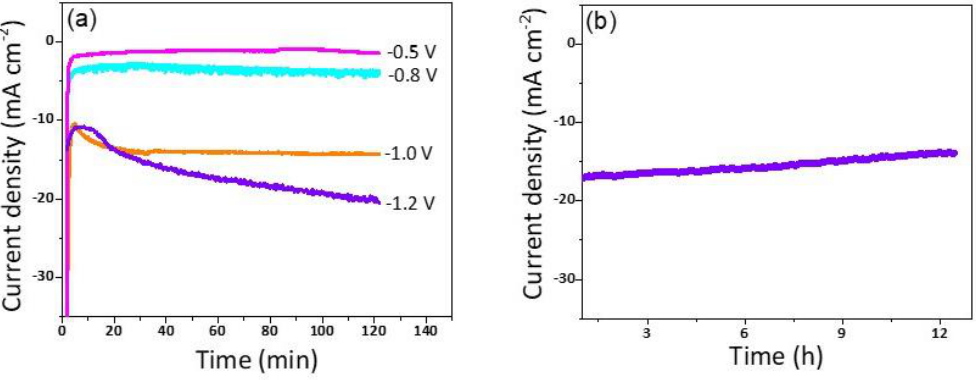
Figure 8. ( a ) The chronoamperometry of Cu/NC-700 at potentials of − 0.5, − 0.8, − 1.0, and − 1.2 V vs RHE for 2 h. ( b ) The long-term stability of Cu/NC-700 at potentials of − 1.0 V vs RHE for 12 h.